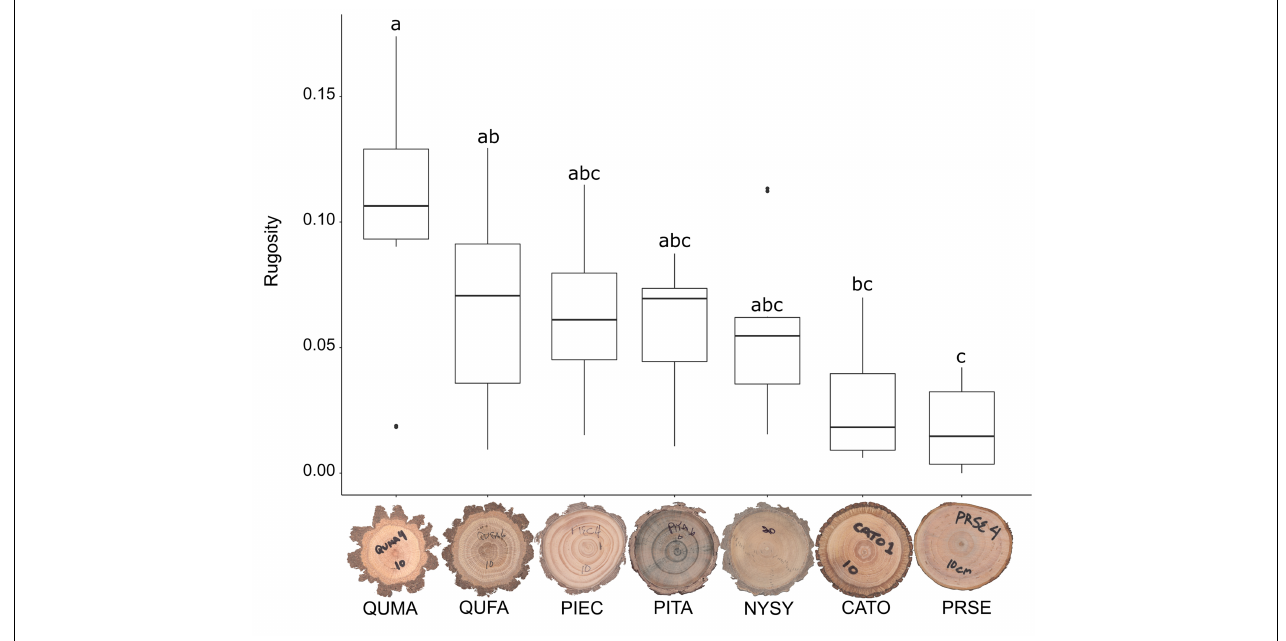
FIGURE 6 | Bark rugosity of basal cross-sections in seven co-occurring tree species. Species codes are as follows: QUMA, Quercus marilandica ; QUFA, Quercus falcata ; PIEC, Pinus echinata ; PITA, Pinus taeda ; NYSY, Nyssa sylvatica ; CATO, Carya tomentosa ; PRSE, Prunus serotina . Horizontal bar in each boxplot represents the median rugosity. Species with the same letter are not statistically different at P =